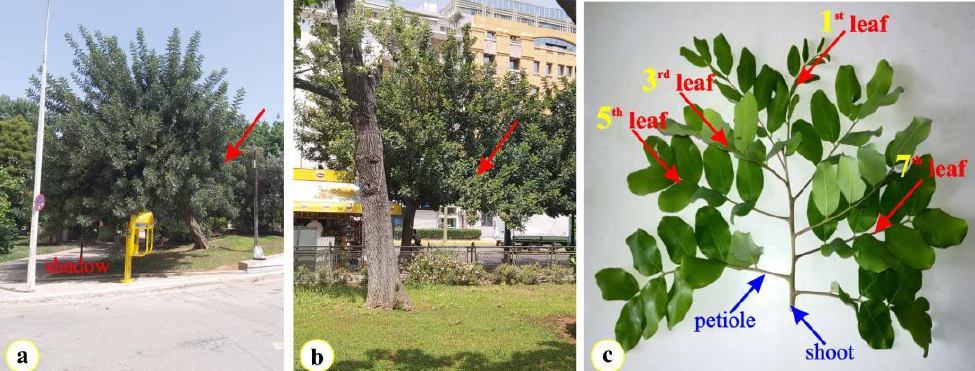
Figure 6. Two, among the five selected trees for sampling, are depicted. ( a ) The carob tree grown in the site Paleo Faliro (PF) and ( b ) in front of the National Garden (NG). The red arrows in ( a ) and ( b ) indicate the meridian site of the carob tree. ( c ) A young shoot from a carob tree; the considered successive compound leaves of C. siliqua used in this investigation are pointed out using arrows.